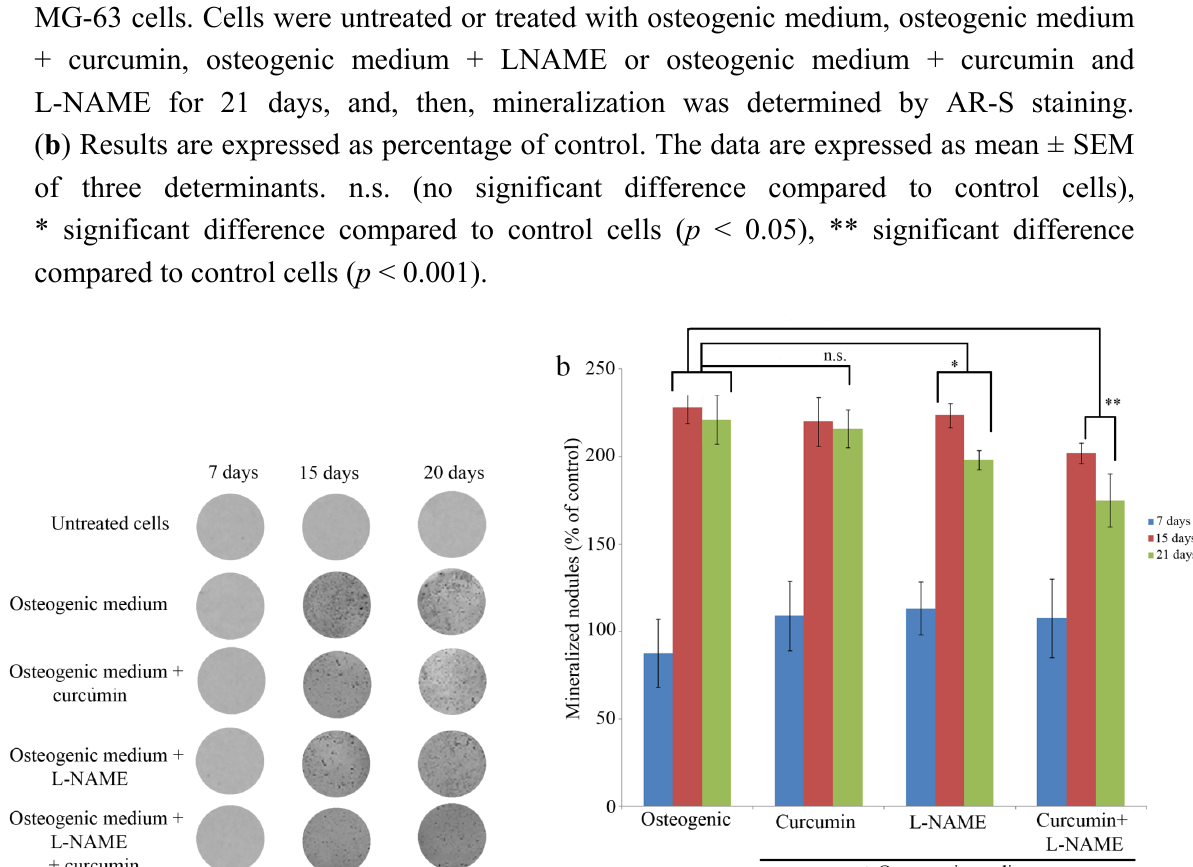
Figure 3. ( a ) Effect of curcumin (10 µM) and L-NAME (1 mM) on mineralized nodules in MG-63 cells. Cells were untreated or treated with osteogenic medium, osteogenic medium + curcumin, osteogenic medium + LNAME or osteogenic medium + curcumin and L-NAME for 21 days, and, then, mineralization was determined by AR-S